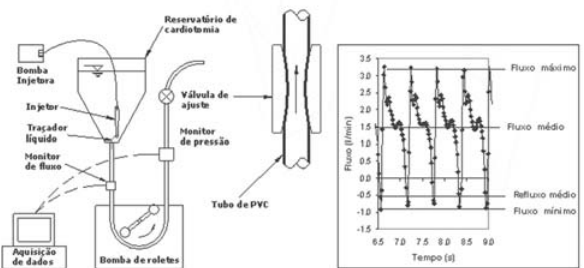
Fig. 3 – Ilustração da configuração usada para visualização em reservatório de cardiotomia (esquerda). Detalhe da válvula de ajuste de pressão (centro). Curva dos registros de fluxo pelo tempo (direita), por conveniência é mostrada apenas com intervalo de